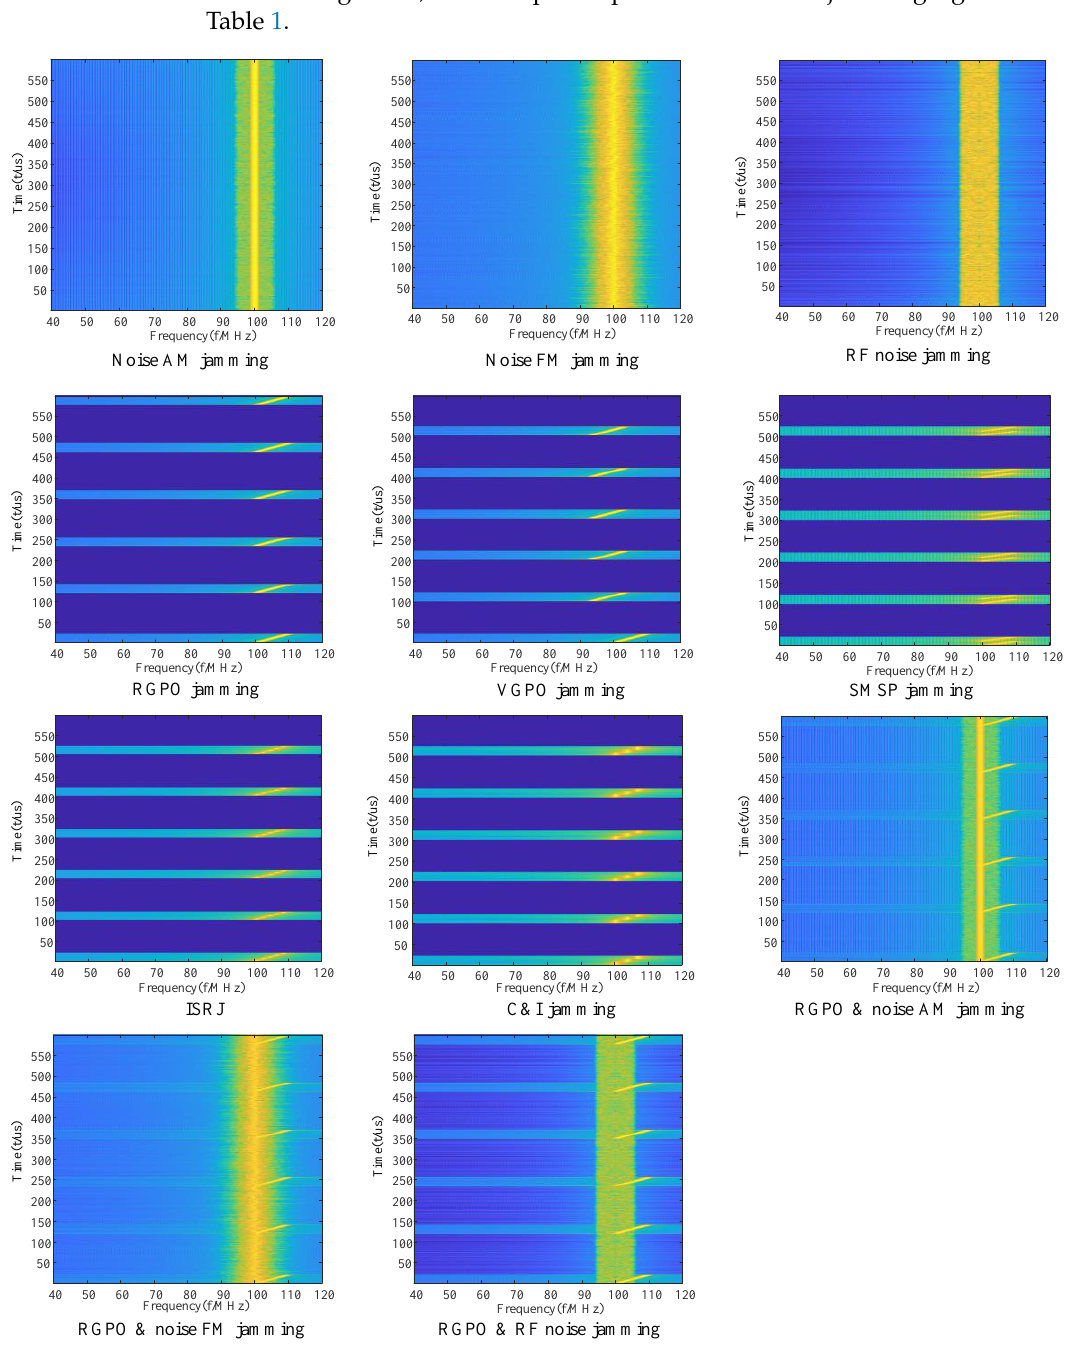
Figure 14. Time-frequency images of jamming signal. Table 1. Radar active jamming dataset parameters settings.